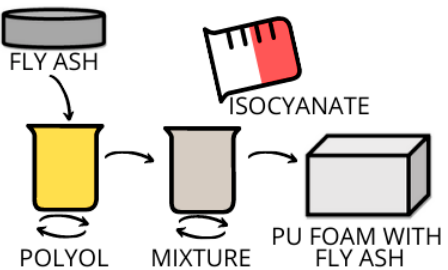
Figure 4. Schematic presentation of the production of polyurethane composites.